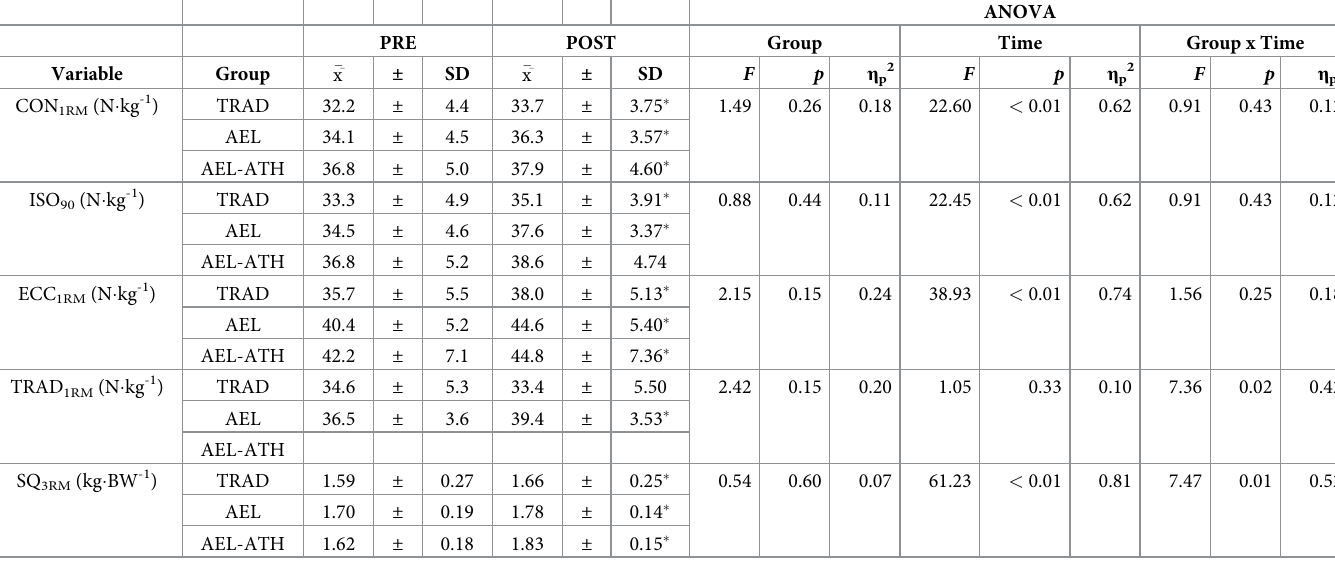
Table 3. ANOVA model statistics, and changes in strength diagnostics following training with (AEL, AEL-ATH) and without (TRAD) augmented eccentric loading. Significant pre- to post-training changes within-group are denoted with � ( p <